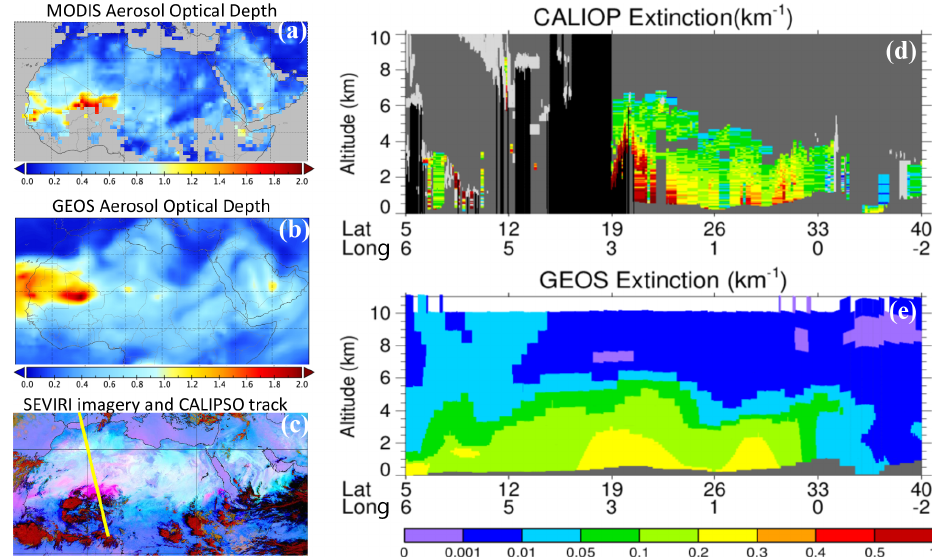
Figure 13. Satellite and GEOS characterizations of dust over North Africa on 14 June 2020: (a) MODIS DB AOD at 550nm, (b) GEOS AOD at 550nm, (c) SEVIRI RGB image (with magenta and dark red denoting dust and mesoscale convective system, respectively) with CALIPSO track (yellow line), and altitude–latitude curtains of aerosol extinction coefficient (unit: km − 1 ) from CALIOP at 532nm (d) and GEOS at 550nm (e) . Hourly GEOS outputs close to the satellite overpassing time are